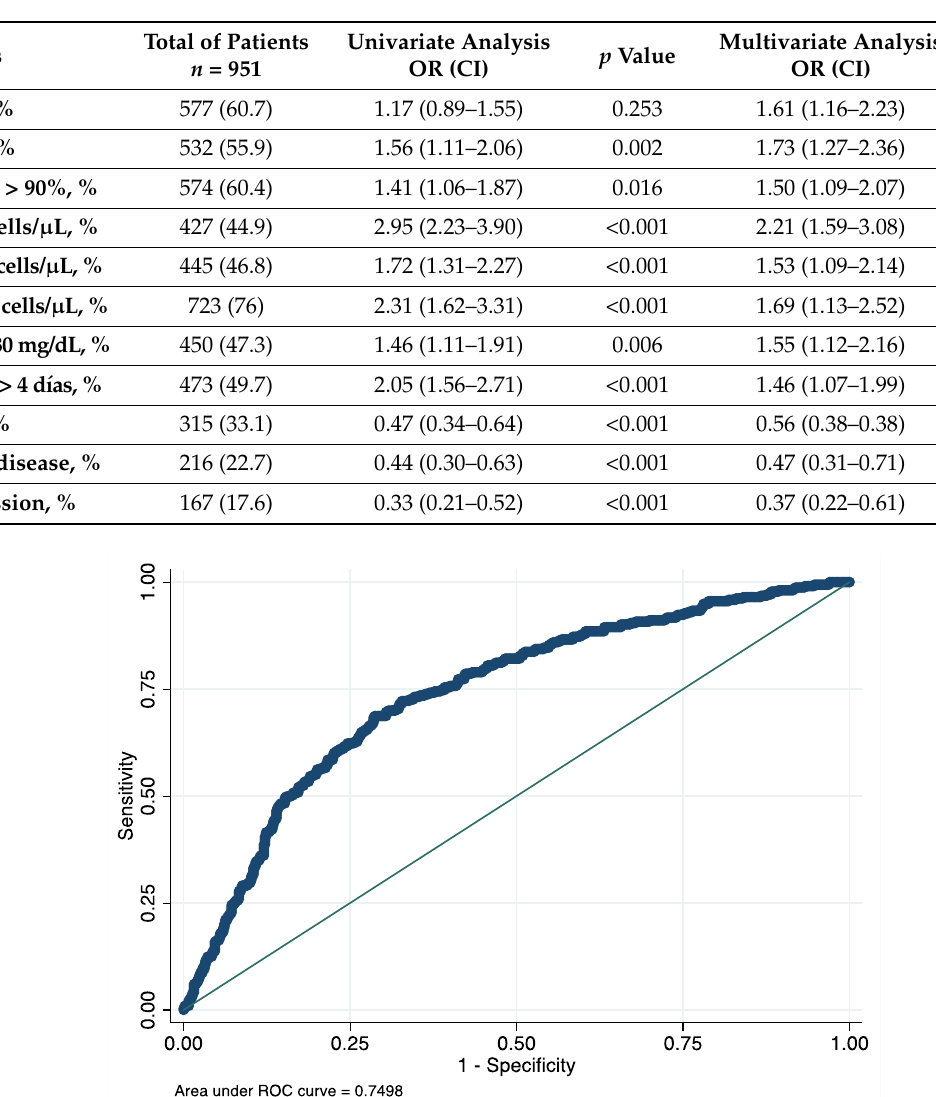
Table 5. Logistic regression model using mortality as the dependent variable and clinical and biochemical determinations with discrimination capacity for exitus in patients with COVID-19.